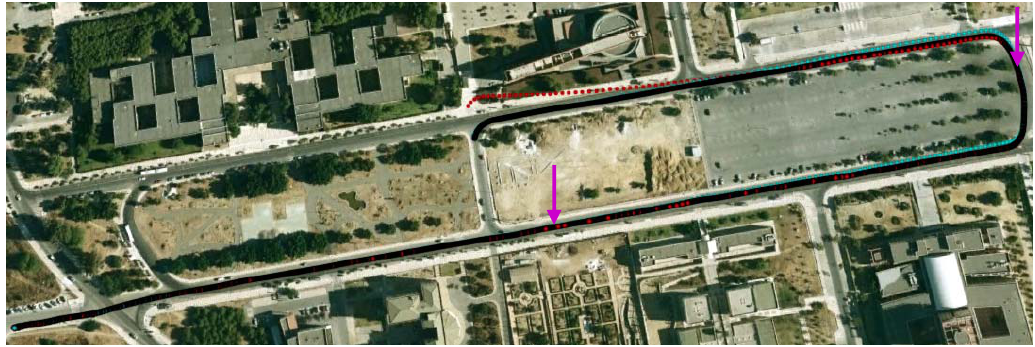
Figure 7. Google Earth visualization of the navigation trajectories (black line: truth trajectory, cyan line: camera/IMU/GNSS integration, red line: tightly coupled GNSS/IMU).